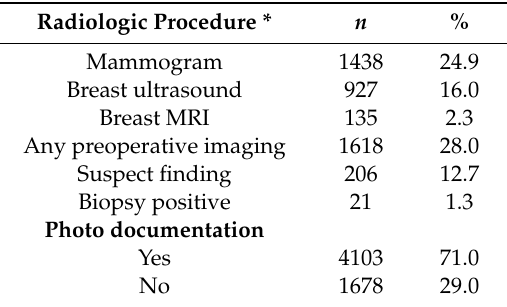
Table 2. Preoperative imaging ( n =